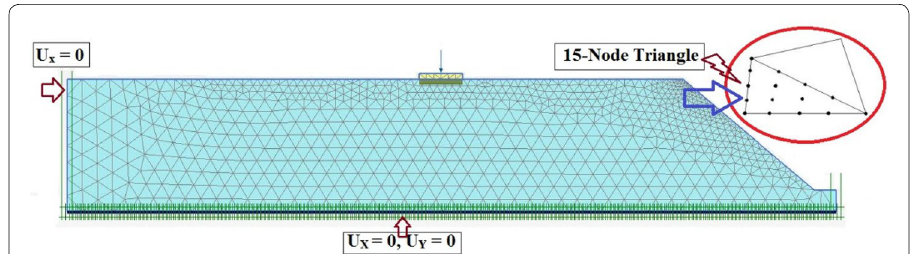
Fig. 2 Typical meshing scheme and standard fixities applied in the numerical model